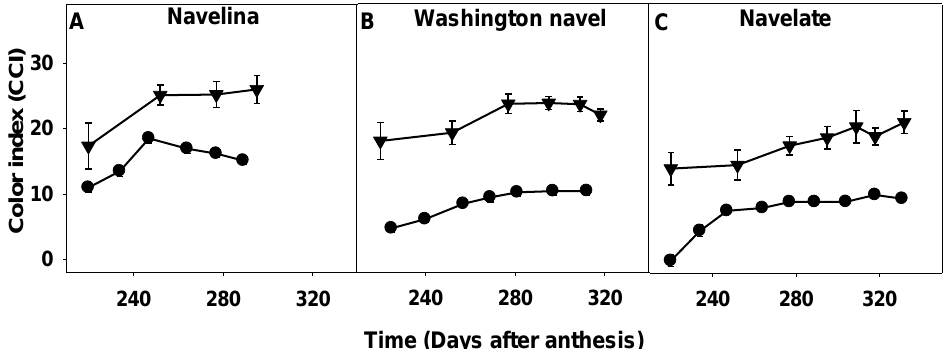
Figure 4. Color index measured in different oranges cultivars during maturation in Corsica ( ▼ ) , Spain ( ● ) and Tunisia ( ■ ). The color index was measured in A ) ‘Navelina’, B ) ‘Washington navel’, C ) ‘Navelate’. Values are means ± SE ( n = 12). Anthesis occurred the first, second and fourth week of April 2012 in Tunisia, Spain and Corsica respectively. Day 150 after anthesis thus corresponds to 09/26/2012 in Corsica, 09/12/2012 in Spain, and 09/07/2012 in Tunisia.